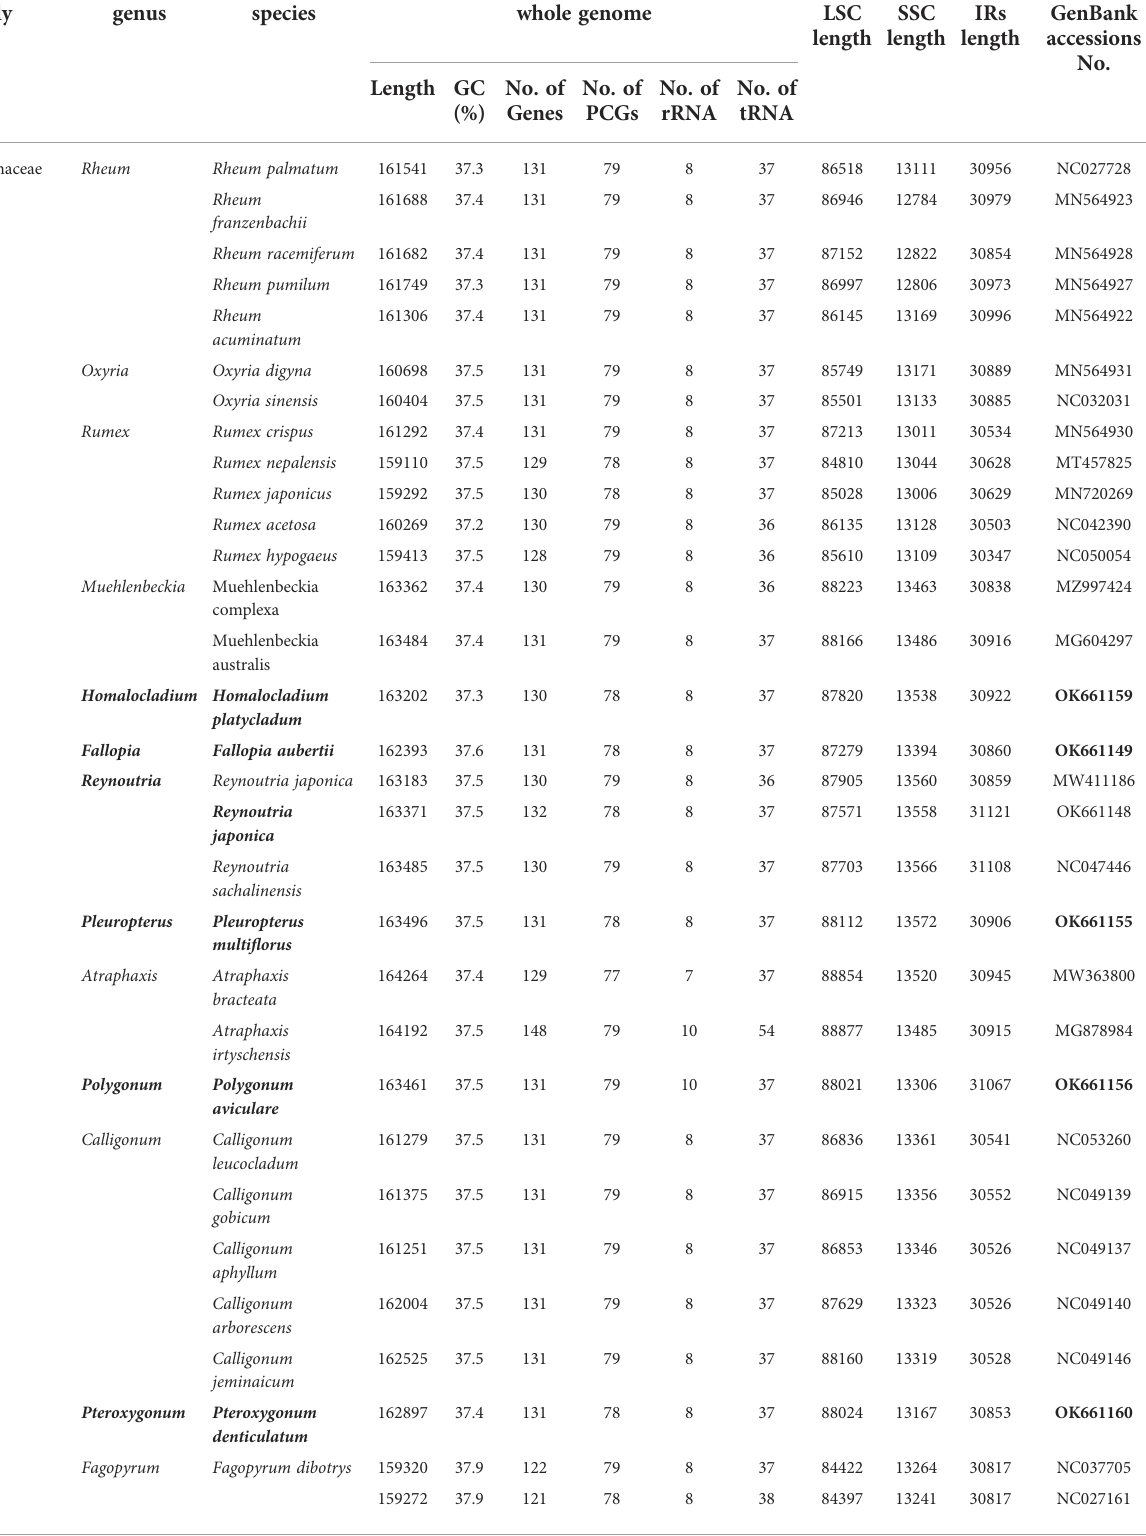
TABLE 1 Summary of major characteristics of all 54 chloroplast genome sequences, including sequence length (bp), numbers of genes, GC content (%), and GenBank accession number. Family genus species whole genome LSC